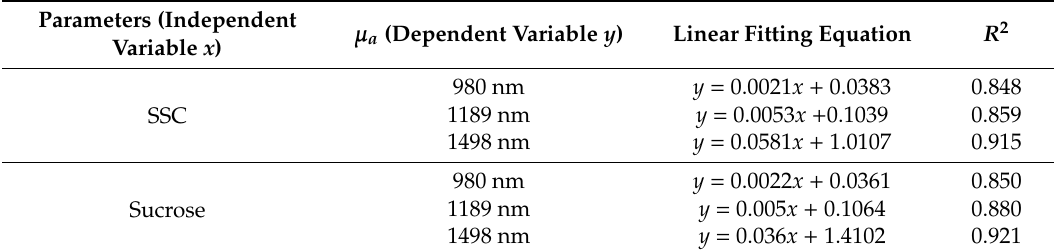
Figure 6. Correlations coe ffi cient of µ a and µ (cid:48) s with content of soluble solid (SSC), total soluble sugars (TSS) and three types of soluble sugars of apples at 25 ◦ C ( a , c ) and 0 ◦ C ( b , d ). Table 3. Linear fitting equations of soluble solid contents, sucrose contents and the absorption coe ffi cients at 980, 1189 and 1498 nm for apple